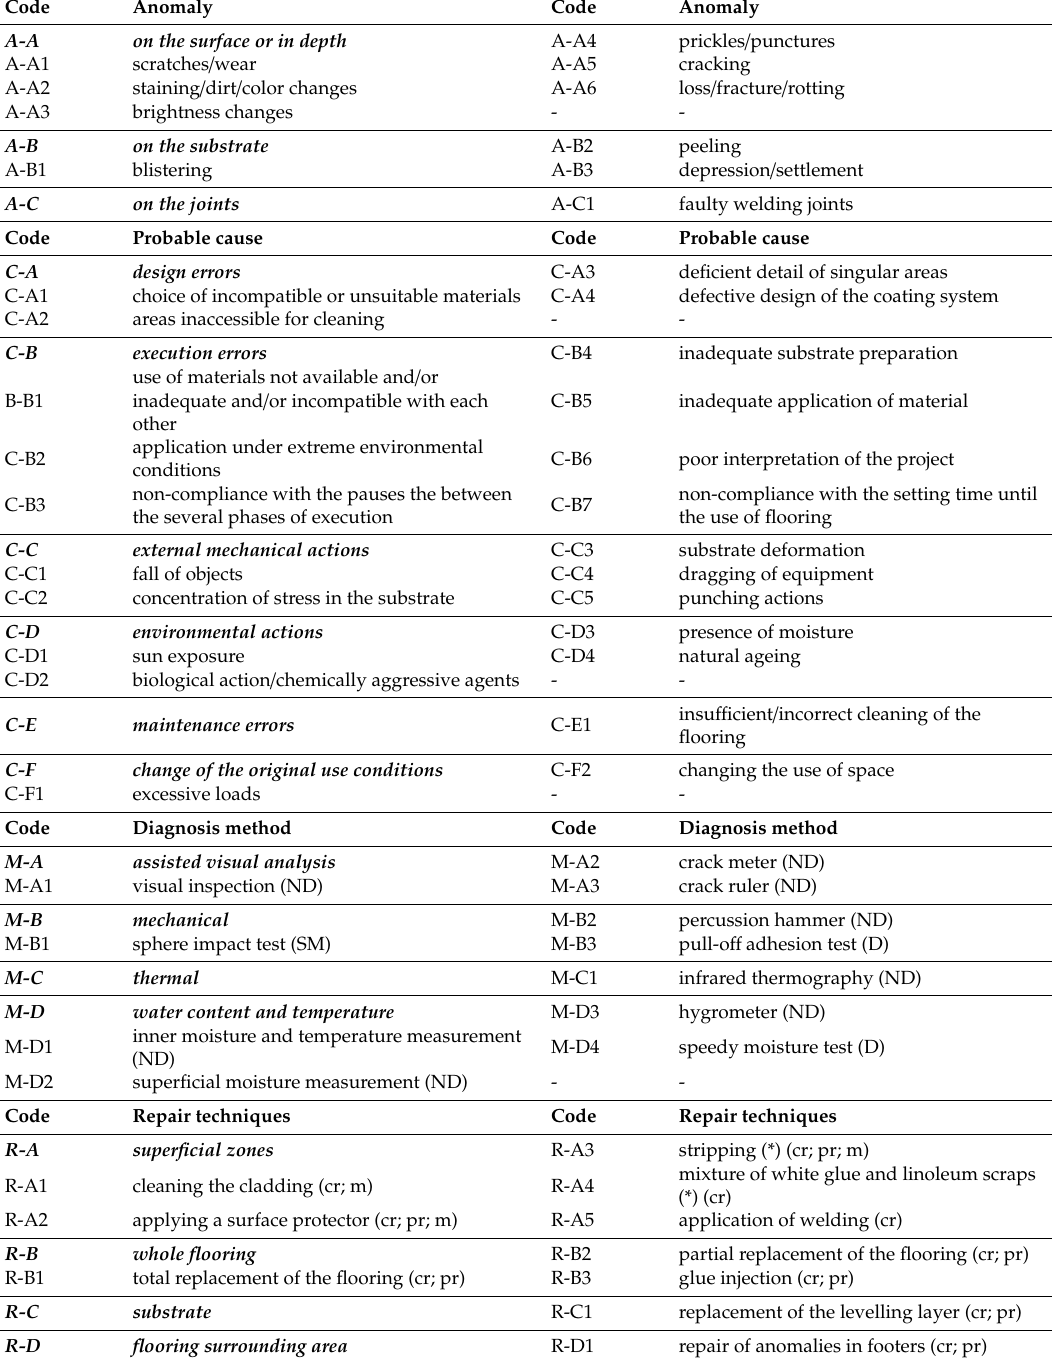
Table 1. Proposed classification of flooring anomalies, their probable causes, diagnosis, and rehabilitation techniques